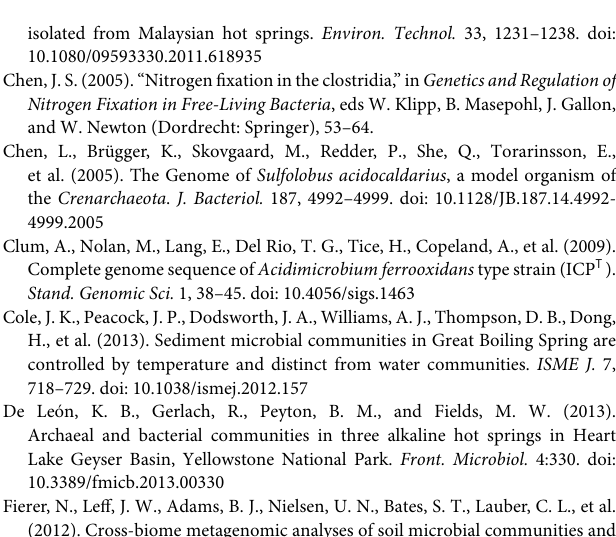
Figure S1 | Rarefaction curves created with MEGAN